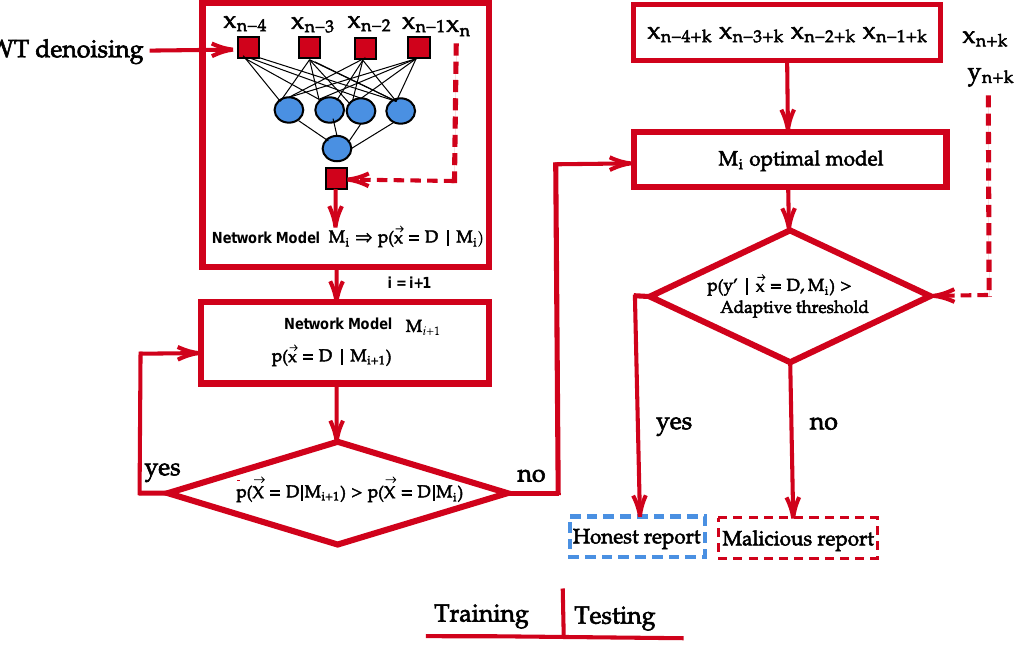
Figure 8. Proposed Approach